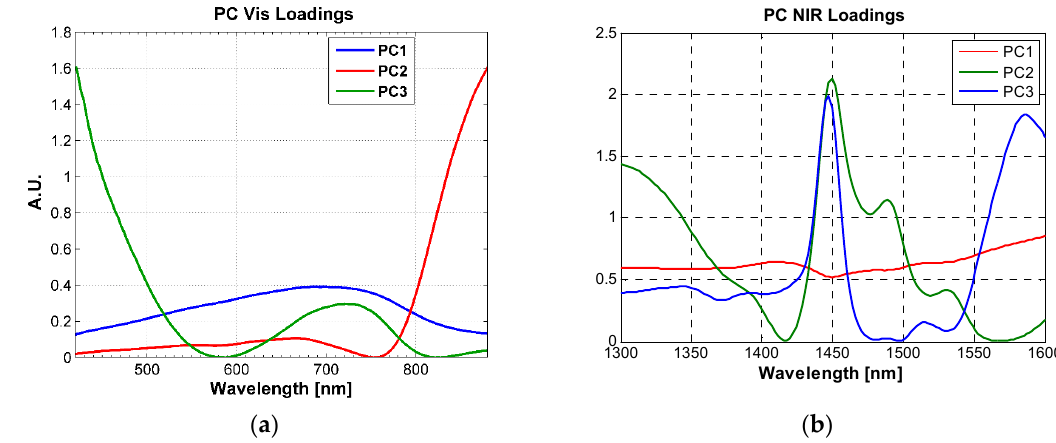
Figure 5. Loading plots of PC1, PC2 and PC3 images calculated in the Vis range (420–880 nm) ( a ) and NIR range (1300–1615 nm) ( b ). Minerals 2020 , 10 , x FOR PEER REVIEW